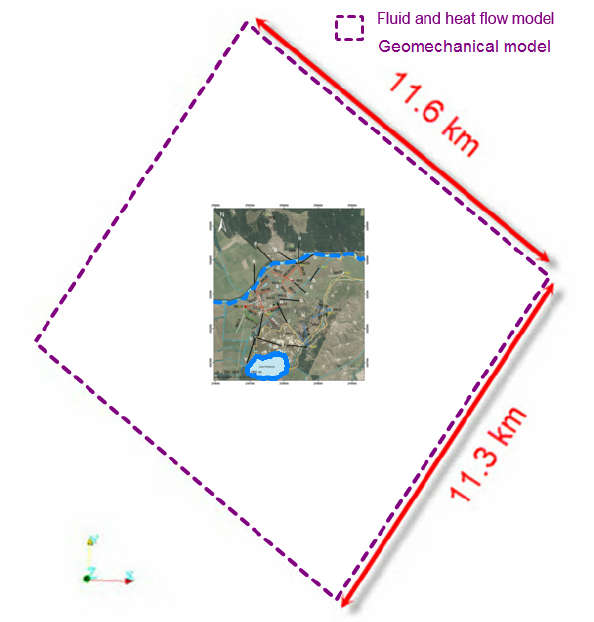
Figure 3. Comparison of model boundaries (top